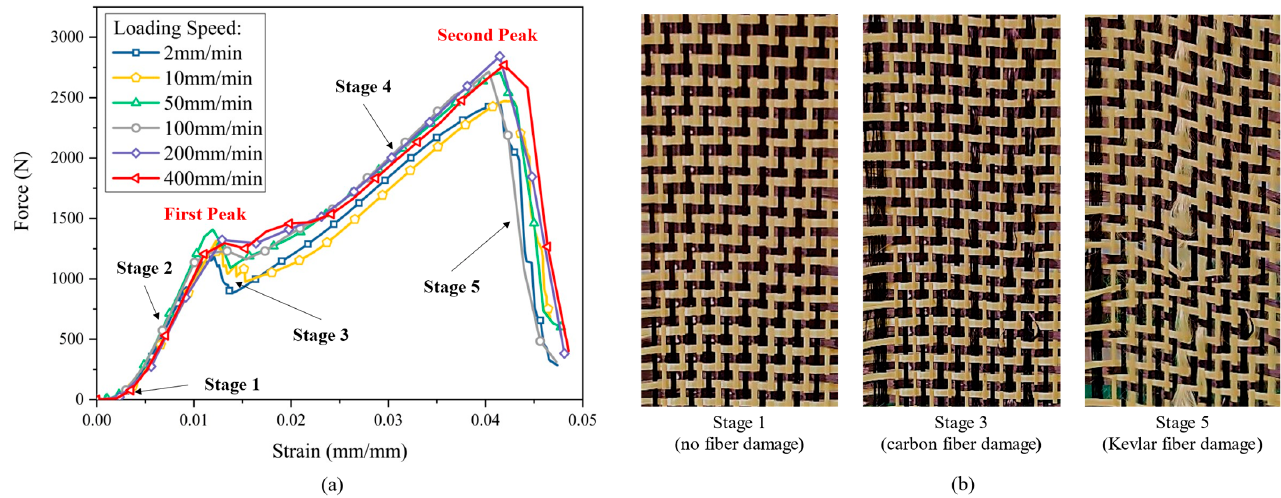
Figure 6. Tensile test results of hybrid woven reinforcement: ( a ) the force-strain relationship under different loading speeds; ( b ) the deformation and damage behaviors in some typical stages.